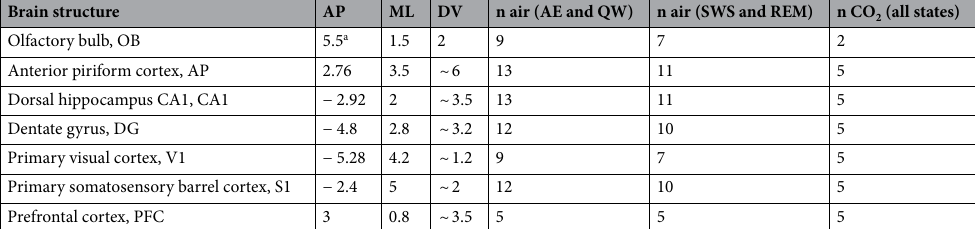
Table 1. Coordinates from bregma (mm) and number of rats (n) in each condition (air and CO 2 ). Note that in air condition, we distinguished awake and sleep states because 2 rats were not recorded in sleep states. a From naso-frontal